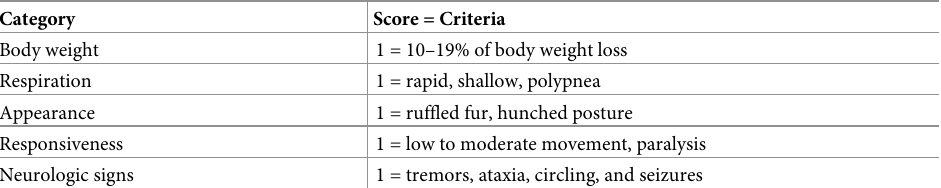
Table 1. Clinical scoring system used for PHEV-infected